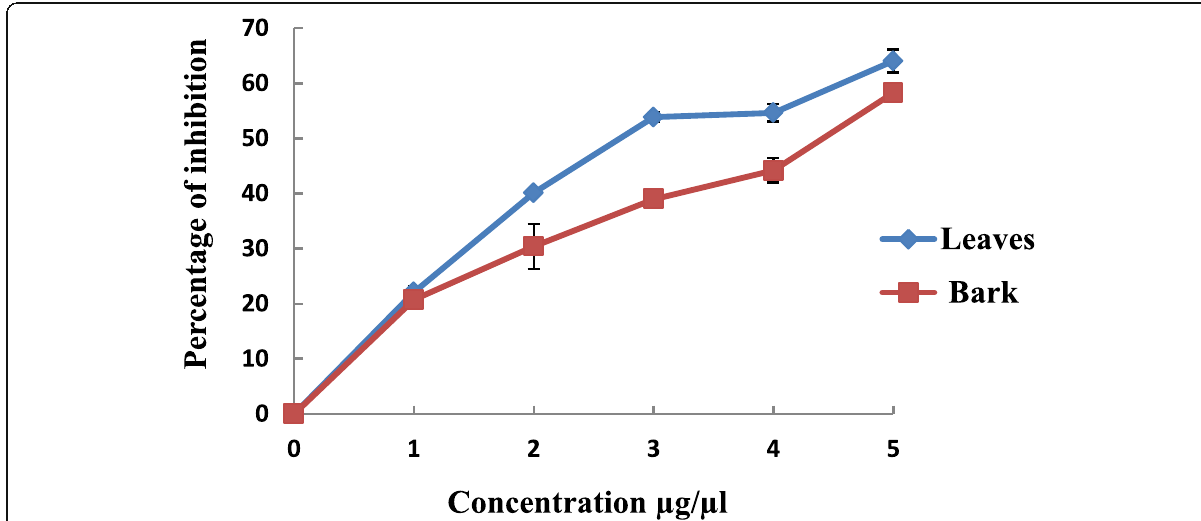
Fig. 8 DPPH radical reducing activity of methanol extracts of S . palghatense leaves and bark. Error bars represent the standard error of observed data in all six